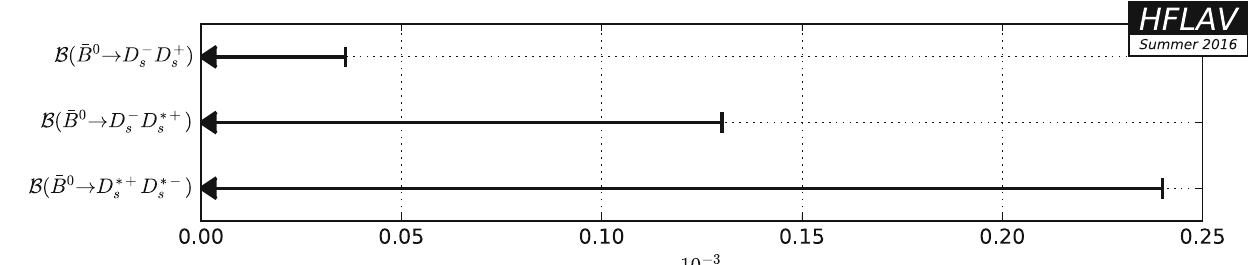
Fig. 86 Summary of the averages from Table 111